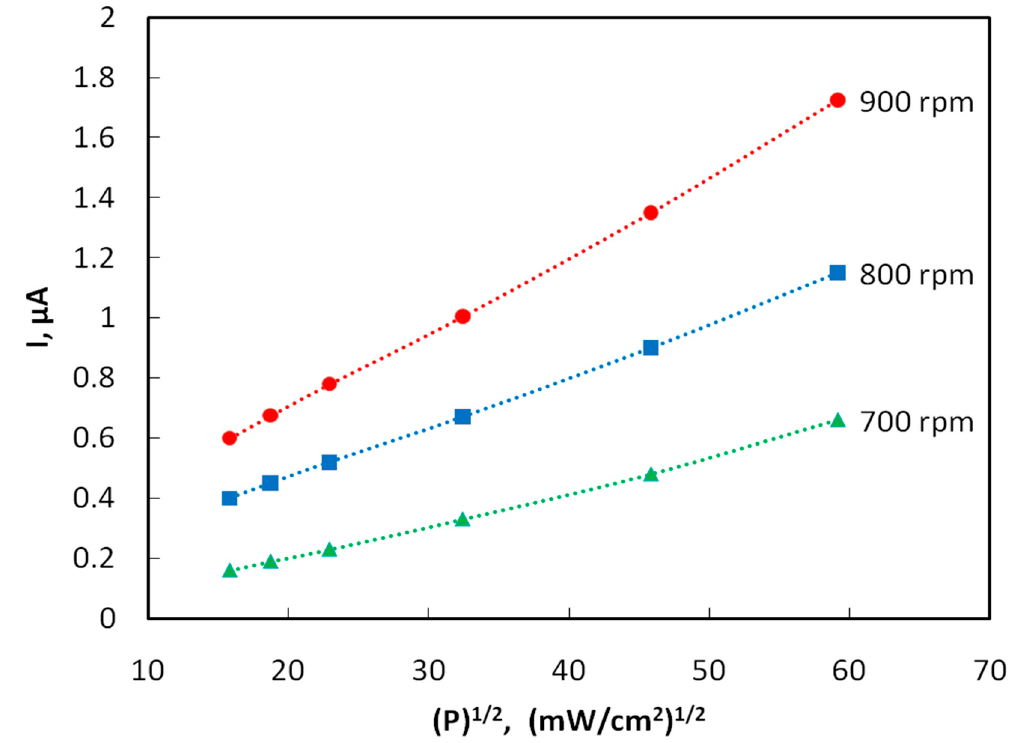
Figure 4. Plots of the photocurrent vs. the square root of the radiation power density for films obtained at different speeds of spin coating. The voltage between the electrodes is U = 10 V.